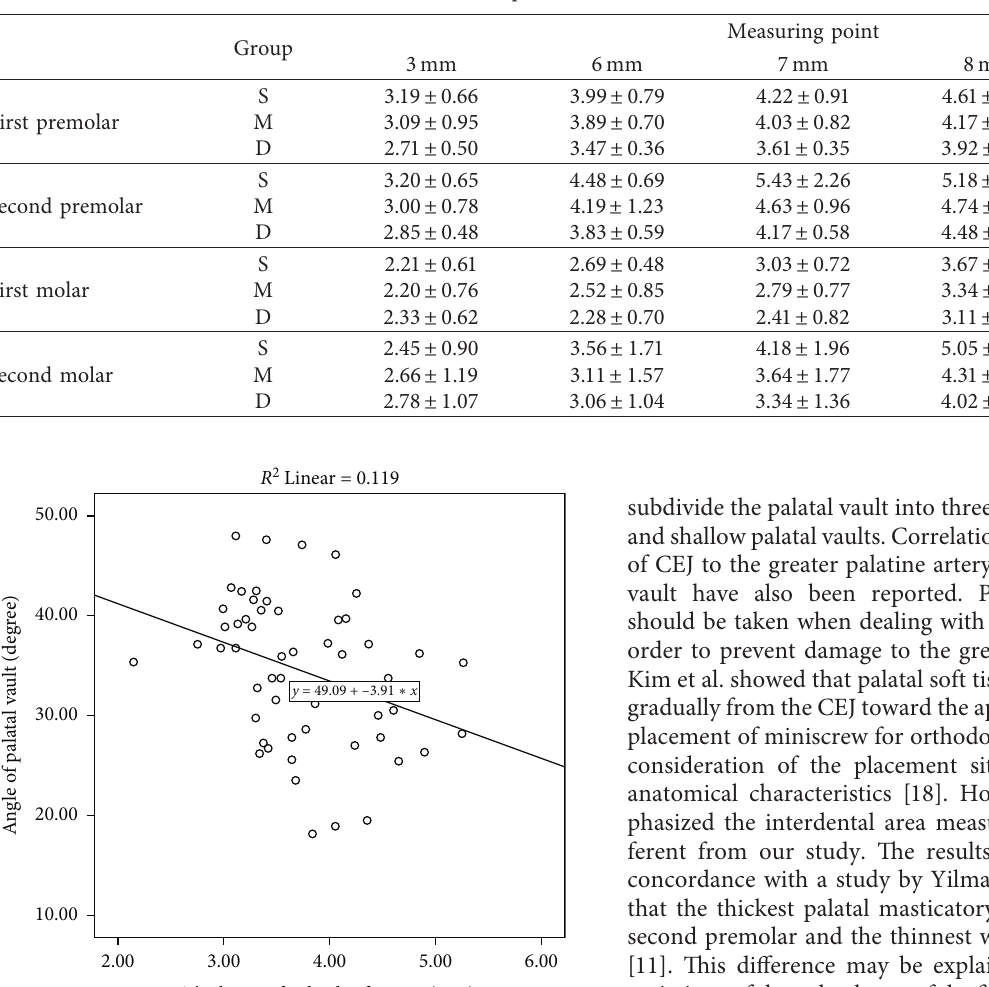
Table 3: Mean and standard deviation of palatal soft tissues measured at 5 different distances from CEJ.